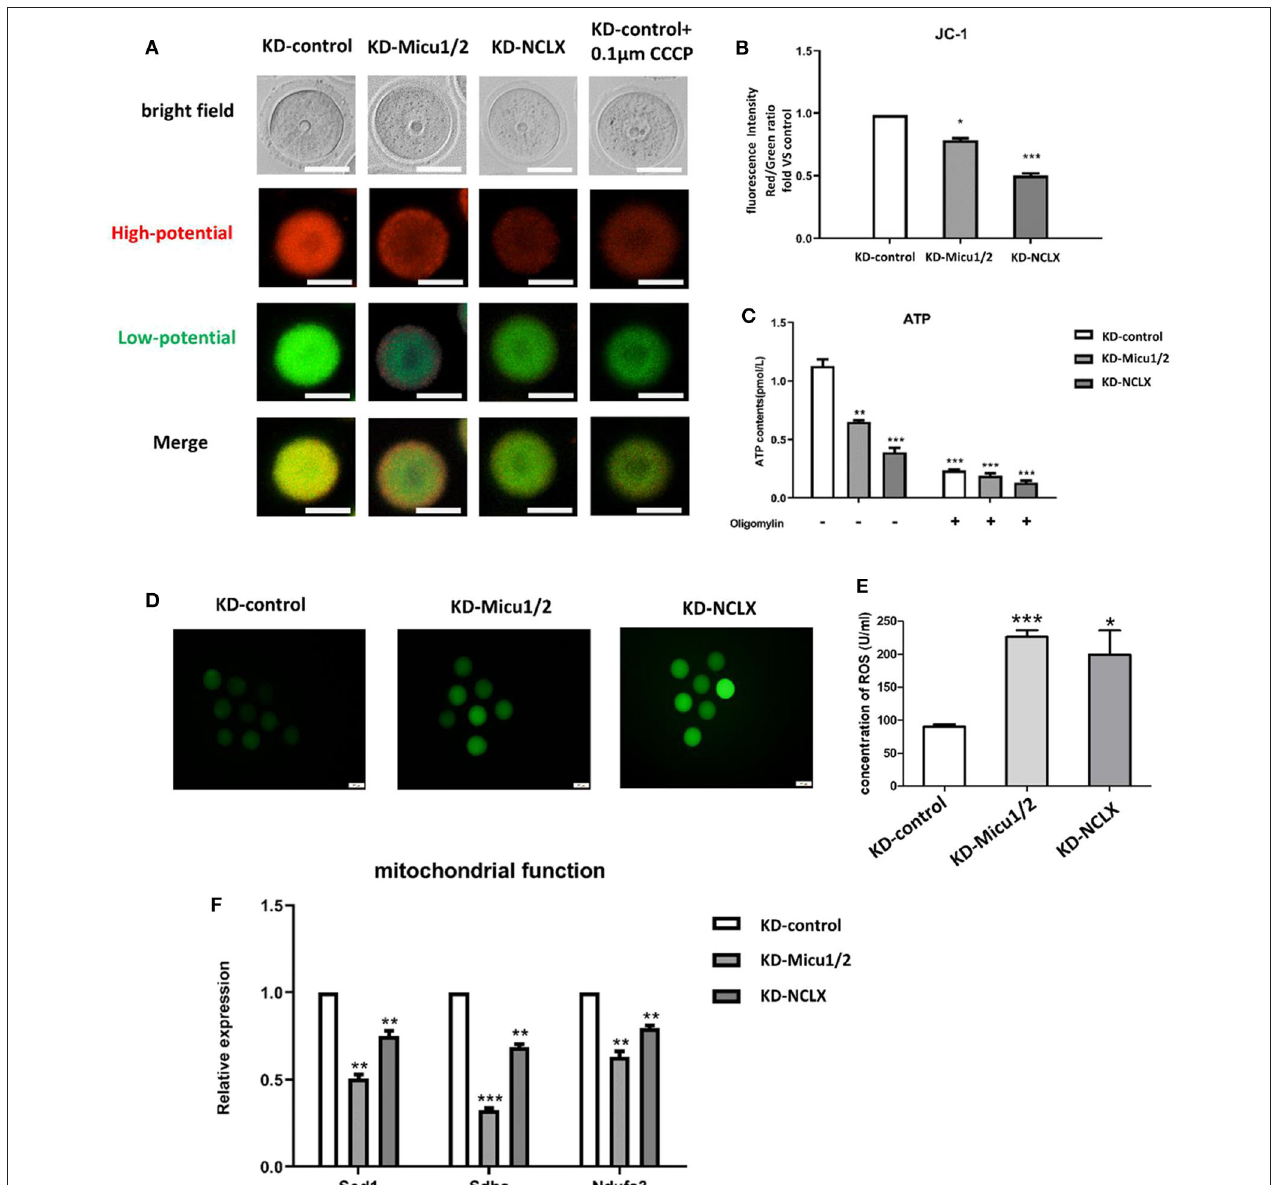
FIGURE 2 | Mitochondrial function is impaired by mitochondrial Ca 2 + overload. (A) Representative images of JC-1 from KD-control, KD-Micu1/2, and KD-NCLX. Scale bar: 50 µ m. (B) Oocytes from KD-control, KD-Micu1/2, and KD-NCLX were stained with JC-1 and quantification of the relative levels of mitochondrial membrane potential ( 1 φ m) in oocytes ( n = 50 for each group). (C) ATP (pM) concentrations were evaluated in individual oocytes from KD-control, KD-Micu1/2, and KD-NCLX ( n = 30 for each group). (D) Representative images of CM-H2DCFDA fluorescence (green) in germinal vesicle (GV) stage oocytes from KD-control, KD-Micu1/2, and KD-NCLX. Scale bar: 50 µ m. (E) Quantification of the relative levels of reactive oxygen species (ROS) in oocytes from KD-control, KD-Micu1/2, and KD-NCLX (U/ml). (F) Expression levels of genes involved in mitochondrial function ( Ndufs3 , Sdha , and Sod1 ) in GV-stage oocytes were reduced with mitochondrial Ca 2 + overload ( n = 30 for each group). Student’s t- test and one-way ANOVA were utilized for statistical analyses. * P < 0.05; ** P < 0.01; *** P < 0.001. Error bars indicate SEM.